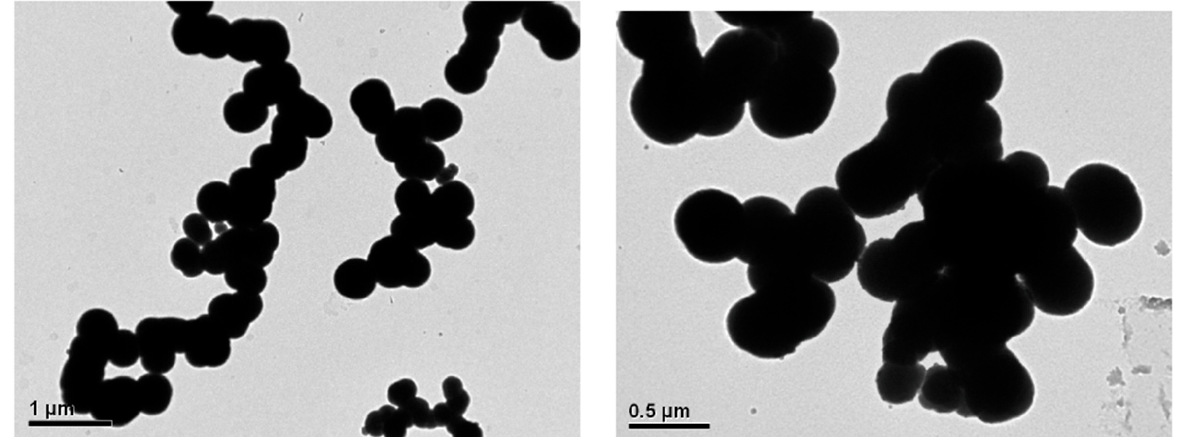
Figure 3. TEM images of nanoMIPs-A ( top ) and nanoMIPs-L ( bottom ). On the left are the images in the 1 µ m scale and on the right 0.5 µ m.